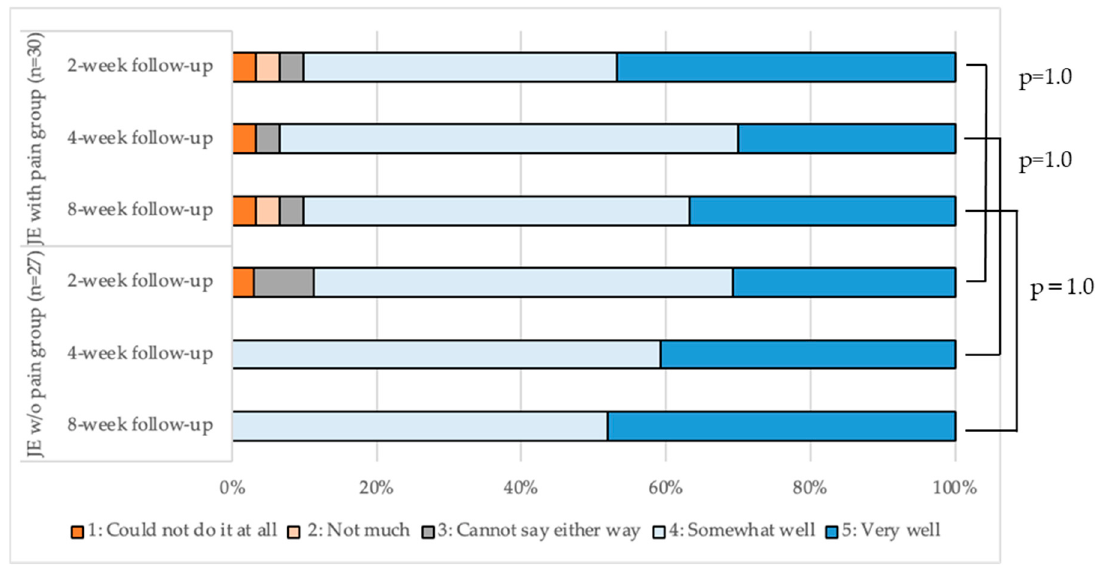
Figure 5. Evaluation of the implementation of the jaw-opening exercise in the two groups.